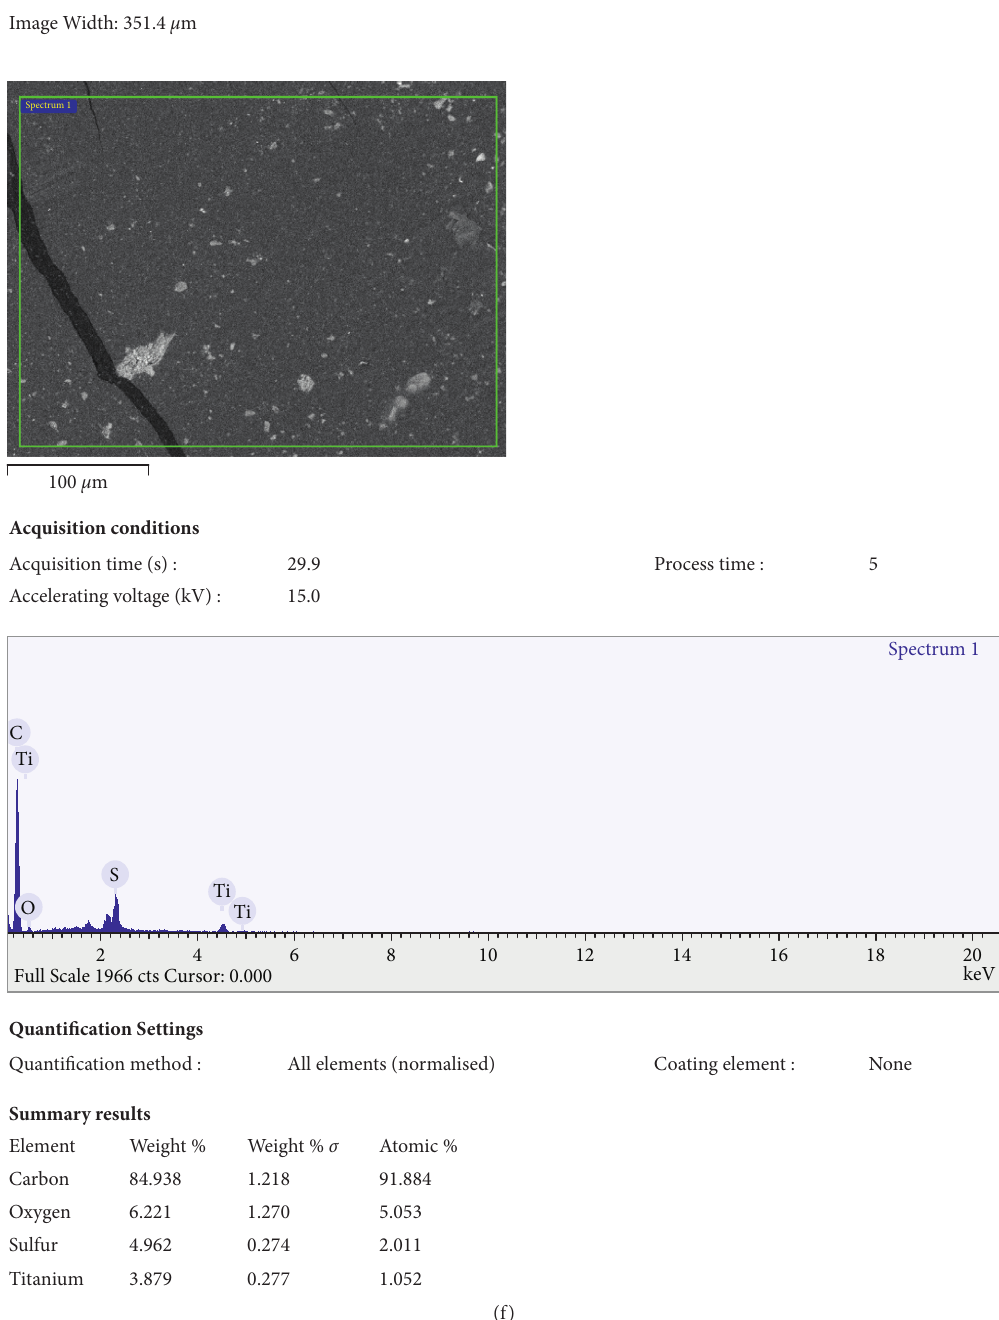
Figure 7: (a) Control Sample. (b) 1% nano TiO 2 modified bitumen. (c) 2% nano TiO 2 modified bitumen. (d) 3% nano TiO 2 modified bitumen. (e) 4% nano TiO 2 modified bitumen. (f) 5% nano TiO 2 modified